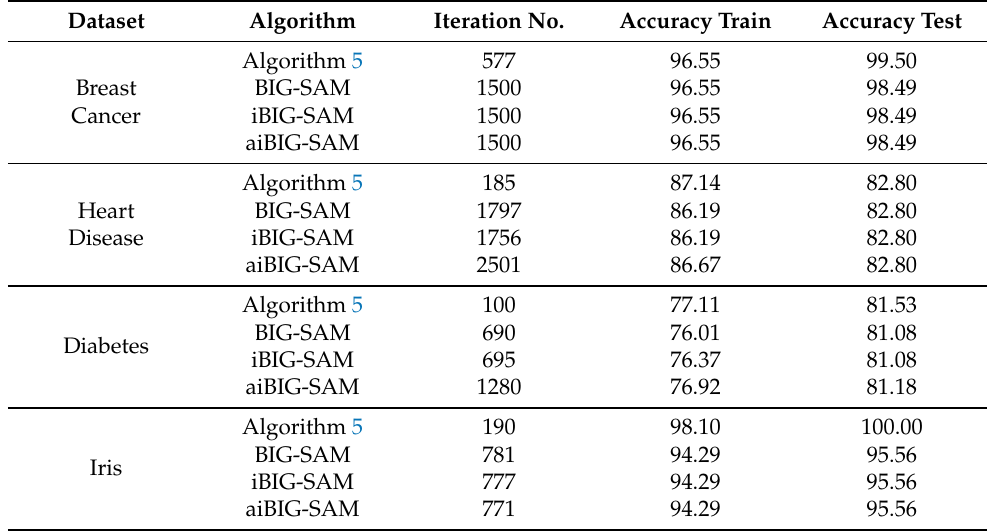
Table 4. The iteration number of each algorithm with the best accuracy on each